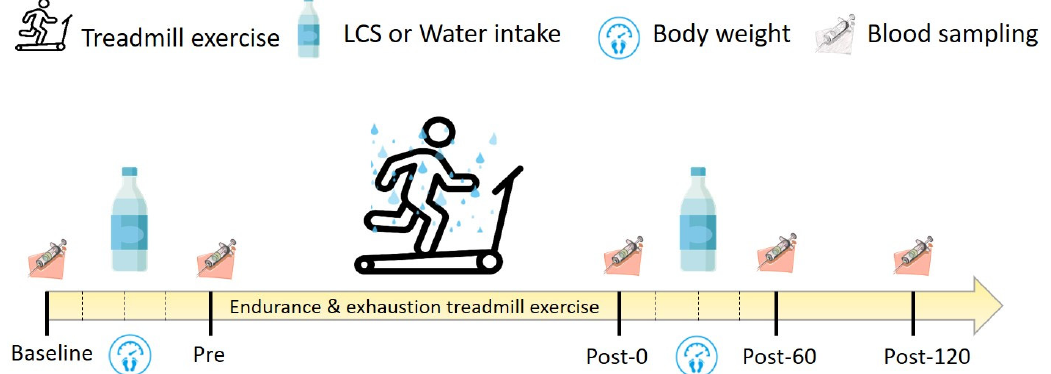
Figure 1. Experimental scheme. The experiment was based on a crossover double-blind design. The participants engaged in the treadmill exercise for 60 min with 70% maximal oxygen consumption ． ． ( VO 2max ) intensity, followed by 90% VO 2max until exhaustion. The indicated fluid was ingested at a rate of 600 mL / h (150 mL / 15 min) before and after exhaustive endurance exercise. The participants’ BW information and blood samples were collected at indicated time points. LCS, low-osmolality carbohydrate–electrolyte solution; Pre, Pre-exercise; Post-0, Immediately after exercise; Post-60, 60 min after exercise; Post-120, 120 min after exercise.